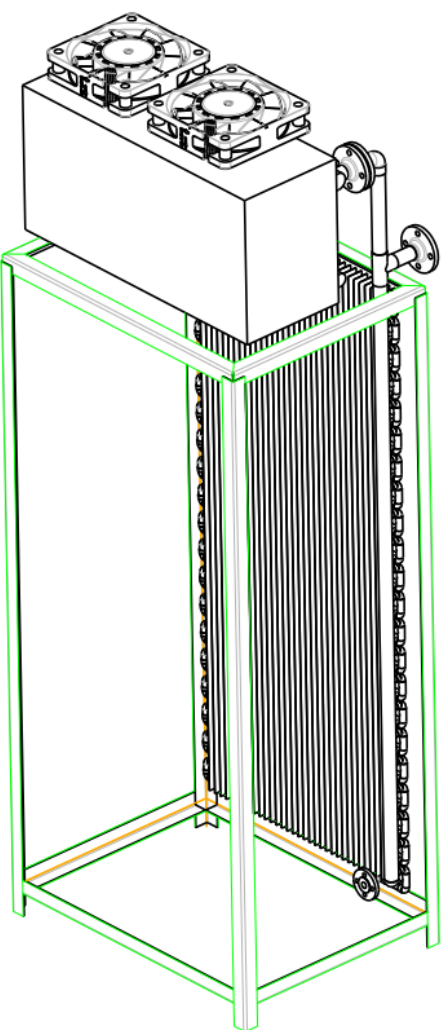
Fig. 1. Electrotechnical box with heat